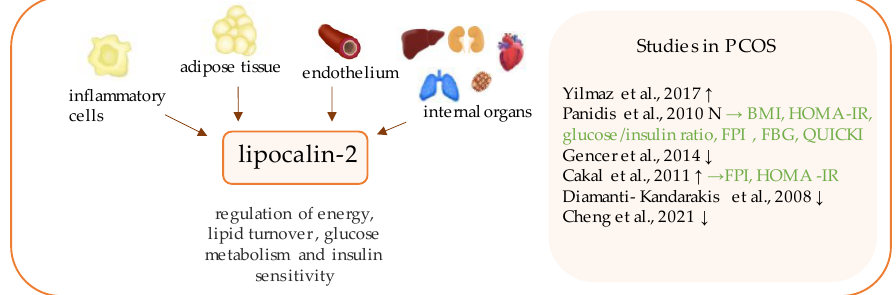
Figure 11. Role of lipocalin-2 in the pathogenesis of insulin resistance and PCOS. List of the studies assessing lipocalin-2 in serum of the patients with PCOS. ↑ / ↓ /N indicates whether concentration level of lipocalin-2 was increased/decreased/unchanged in PCOS individuals ( p < 0.05); → (green)— indicates positive correlation between serum lipocalin-2 and particular indicators; BMI—body mass index; HOMA-IR—Homeostatic Model Assessment—Insulin Resistance; FPI—fasting plasma insulin; FBG—fasting blood glucose; QUICKI—quantitative insulin sensitivity check index.